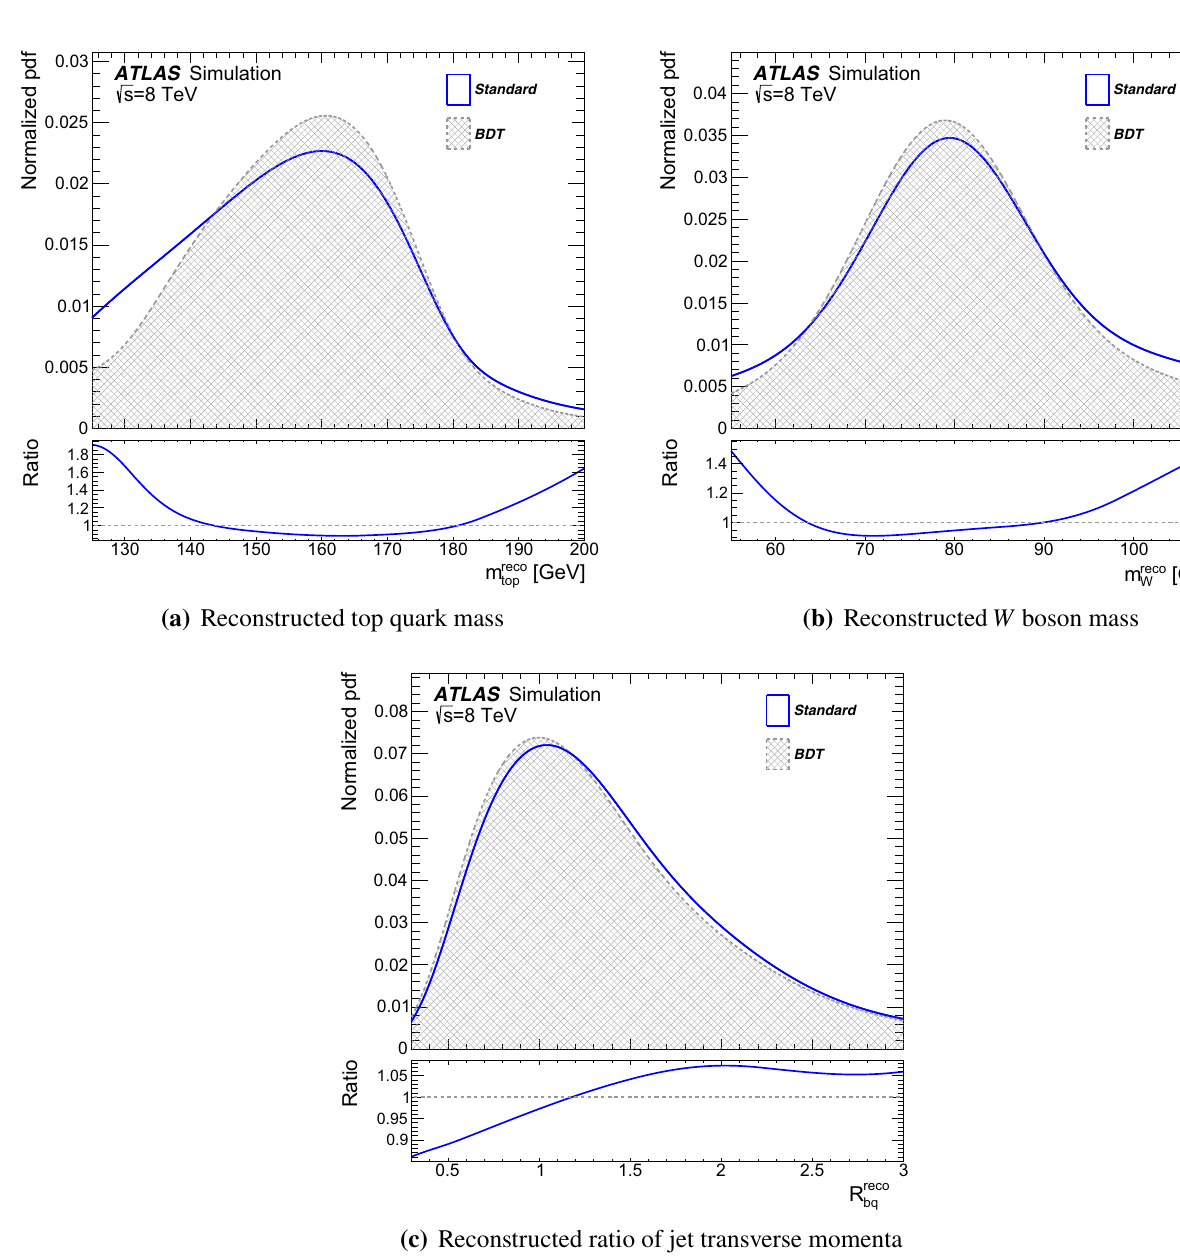
Fig. 12 Comparison of the template fit functions of the three observ- ables for the standard event selection (solid line) and the BDT event selection (dashed line). The ratios (standard/BDT) of the pairs of func-